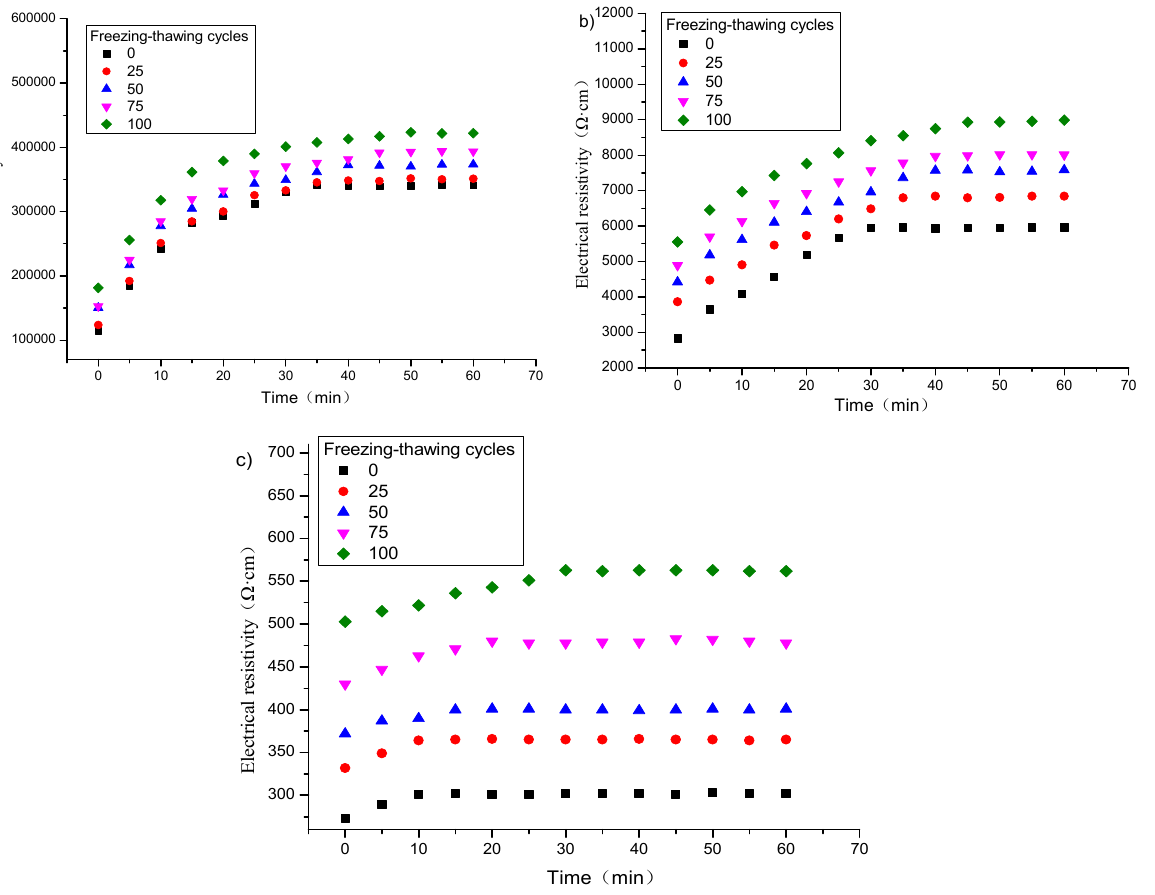
Figure 2. Polarization effect of specimens with different graphene content after different freezing and thawing cycles: ( a ) 1%; ( b ) 2%; ( c ) 3%. Table 6. Polarization time of specimens with different graphene content after different freeze–thaw cycles. Graphene